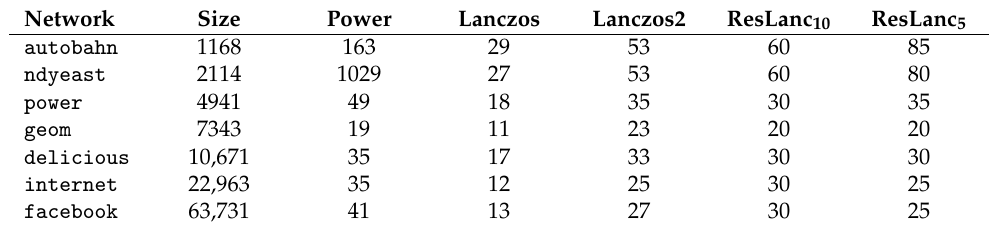
Table 2. Number of matrix–vector product evaluations required by the methods to reach